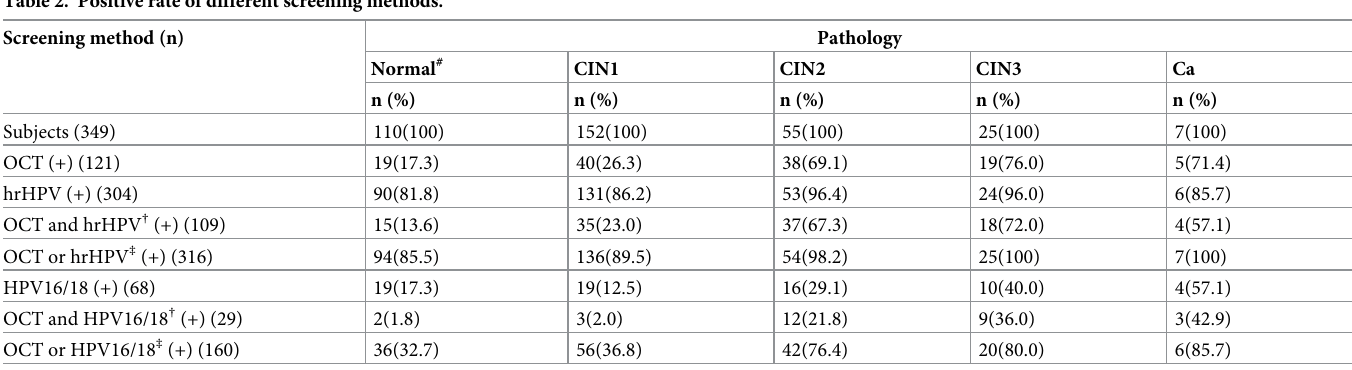
Table 2. Positive rate of different screening